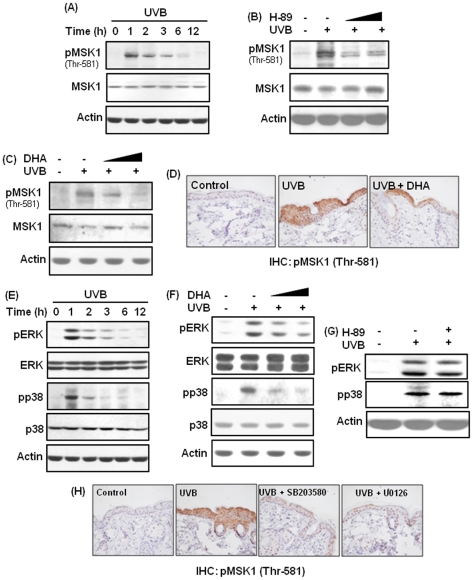
DHA inhibits UVB-induced phosphorylation of MSK1 by blocking ERK and p38 MAP kinase in mouse skin.(A,E) Mice (n = 3 per group) were irradiated with UVB (180 mJ/cm2) and sacrificed at indicated time periods. (A) Tissue lysates were separated by 10% SDS-polyacrylamide gel, transferred to PVDF membrane and immunoblotted to detect the expression of phosphorylated (threonine 581) MSK1. Figure S1A represents the statistical analysis of image density of UVB-induced expression of phospho-MSK1. (B–D, F–H) Animals were treated topically with H-89 (25 or 100 nmol/mouse), DHA (2.5 or 10 µmol/mouse), U0126 (5 µmol/mouse) or SB203580 (5 µmol/mouse) 40 min before exposure to UVB and were sacrificed 1.5 h post-irradiation. (B) Epidermal lysates from mice irradiated with UVB in presence or absence of H-89 (25 or 100 nmol/mouse) were immunoblotted for detecting the expression of MSK1 and phospho-MSK1. Figure S1B represented the densitometric analysis of immunoblots. (C) Epidermal protein extracts from mice irradiated with UVB with or without pretreatment with DHA (2.5 or 10 µmol) were subjected to Western blot analysis to detect the expression of MSK1 and pMSK1 (threonine 581). Figure S1C illustrated the quantification of band intensity of phospho-MSK1. (D) Immunohistochemical analysis of pMSK1 expression in mouse epidermis upon irradiation with UVB in presence or absence of DHA. (E) Epidermal lysates were subjected to Western blot analysis to examine the expression of phosphorylated ERK and p38 MAP kinase upon UVB irradiation. Quantification and statistical analysis of immunoblots were presented in Figure S1D. (F) Inhibitory effects of DHA on UVB-induced phosphorylation of ERK and p38 MAP kinase. Figure S1E represents the quantification data of phospho-ERK and phospho-p38 MAP kinase. (G) Effect of H-89 on the phosphorylation of ERK and p38 MAP kinase in UVB-irradiated mouse skin. Assessment of relative band intensity was presented in Figure S1F. (H) Skin samples from mice pretreated with SB203580 or U0126 (each 5 µmol in 0.2 ml acetone) and irradiated with UVB were subjected to immunohistochemical analysis. Positive phospho-MSK1 staining yielded a brown-colored product.